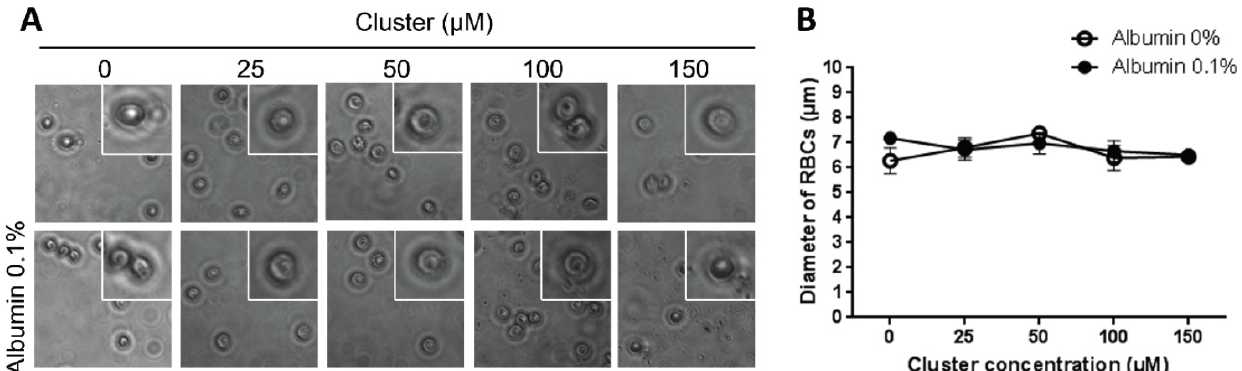
Figure 3. Exposition during 24 h to increasing doses of the cluster did not induce hemolysis in vitro . The percentage of hemolysis after 24 h of incubation is shown. Erythrocytes suspended in distilled water were considered 100% hemolyzed. High doses of the cluster did not increase hemolysis in vitro , compared to controls, and albumin co-incubation showed a tendency to reduce hemolysis (not significant).